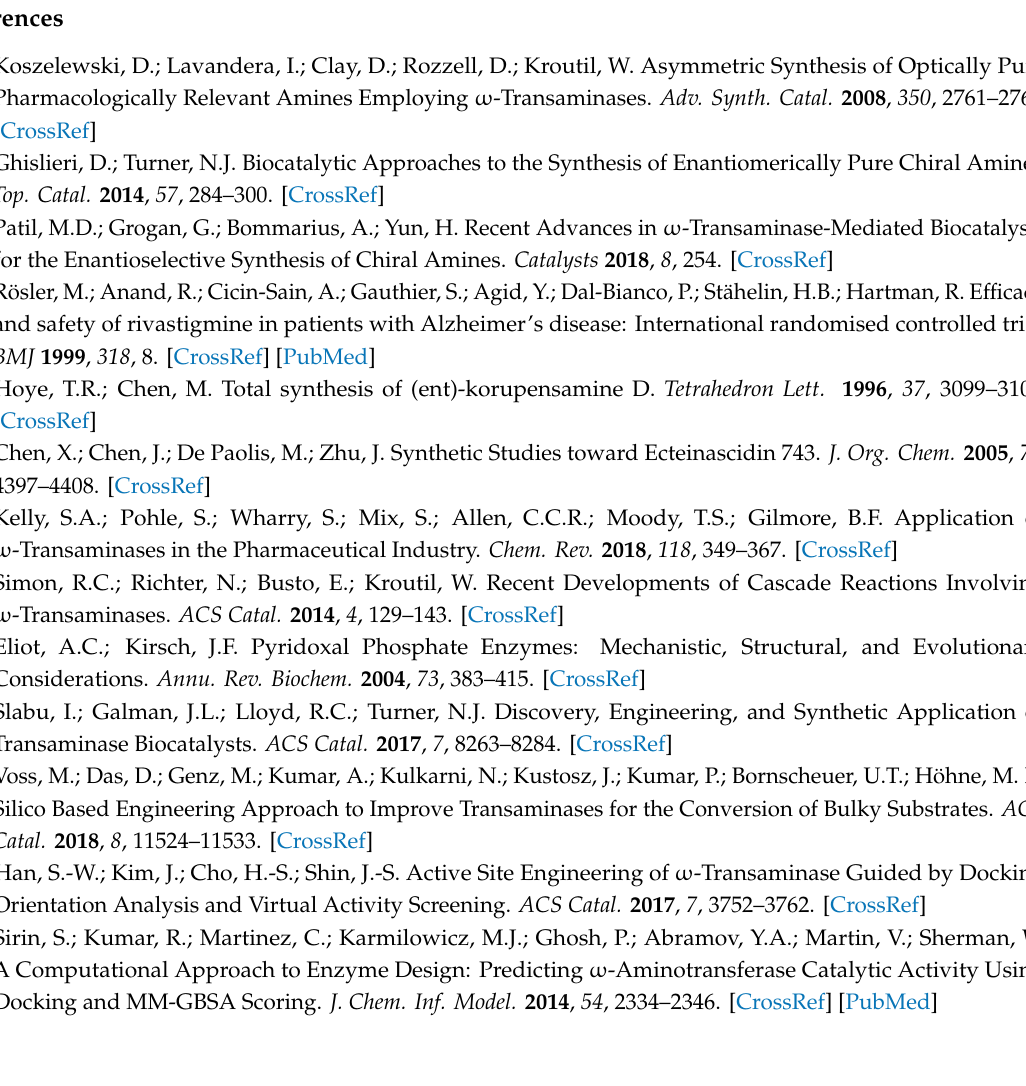
Figure S5: Representative chromatogram of Pj TA-R6-catalyzed transamination of 2-heptanone yielding 2-aminoheptane ( A4 ) after product derivatization; Figure S6: Representative chromatogram of Pj TA-R6-catalyzed transamination of 2-octanone yielding 2-aminooctane ( A5 ) after product derivatization; Figure S7: Representative chromatogram of Pj TA-R6-catalyzed transamination of 3-methyl-2-butanone yielding 3-methyl-2-butanamine ( B1 ) after product derivatization; Figure S8: Representative chromatogram of Pj TA-R6-catalyzed transamination of 3,3-dimethyl-2-butanone yielding 3,3-dimethyl-2-butanamine ( B2 ) after product derivatization; Figure S9: Representative chromatogram of Pj TA-R6-catalyzed transamination of 4-methyl-2-pentanone yielding 4-methyl-2-pentanamine ( B3 ) after product derivatization; Figure S10: Representative chromatogram of Pj TA-R6-catalyzed transamination of 1-cyclopropylethanone yielding 1-cyclopropylethanamine ( C1 ) after product derivatization; Figure S11: Representative chromatogram of Pj TA-R6-catalyzed transamination of 1-cyclohexylethanone yielding 1-cyclohexylethanamine ( C2 ) after product derivatization; Figure S12: SDS-PAGE analysis of purified Cv TA, Vf TA, and Pj TA-R6; Table S1: The retention times of the derivatized